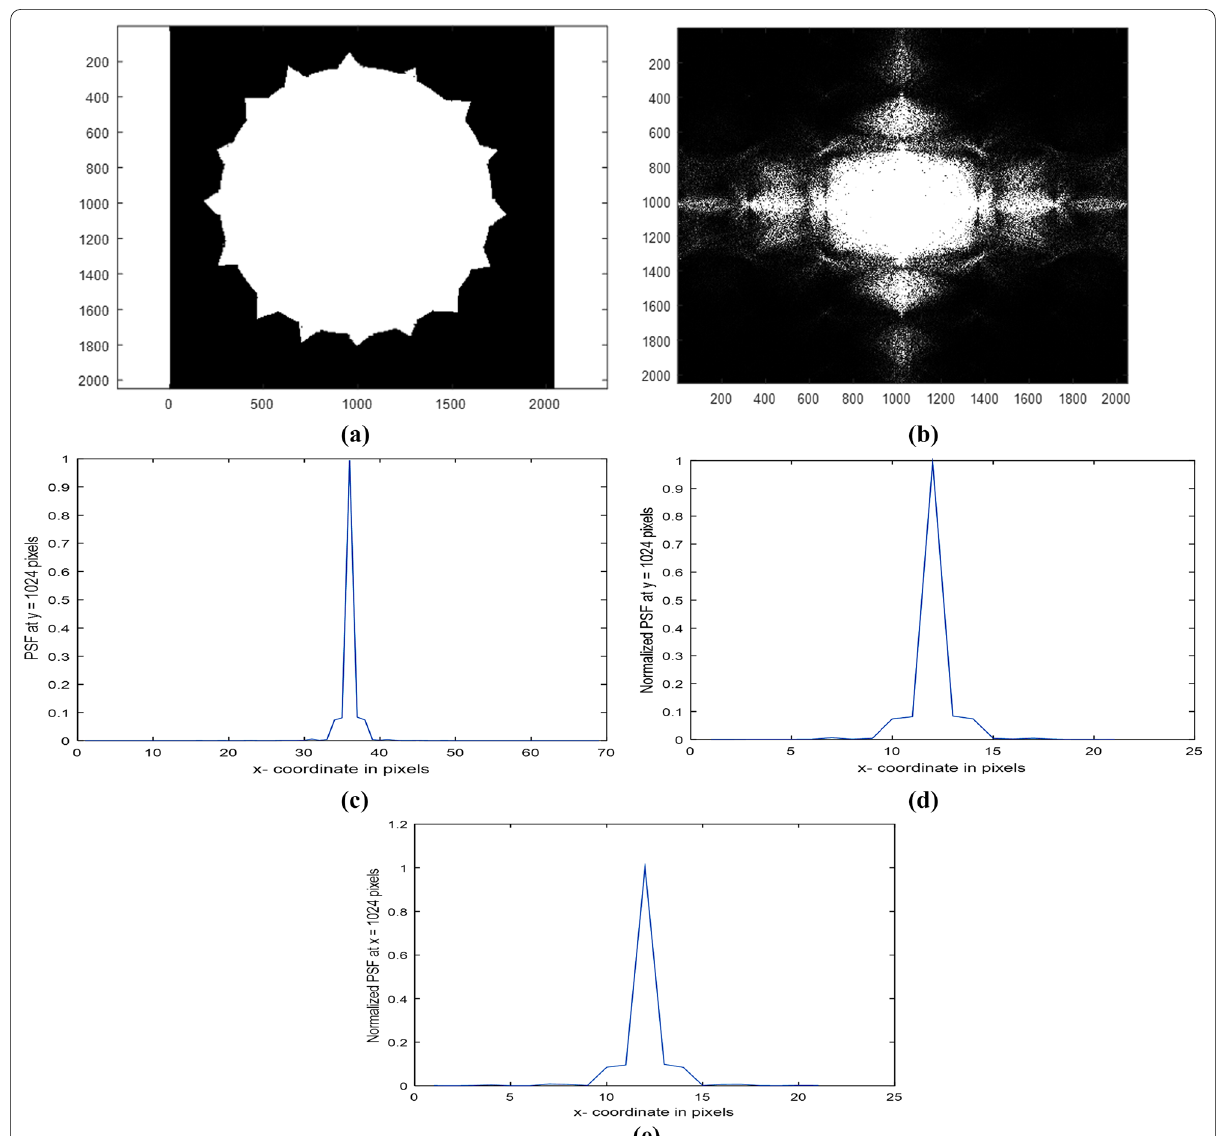
Fig. 4 a Uniform circular aperture with 16 spikes in a matrix of dimensions 2048 image or the intensity impulse response is corresponding to the aperture of 16 spikes shown in ( a ). c : The Normalized PSF plot in the range from 990 up to 1058 pixels is corresponding to the image shown in the (4- a). (4- d): The Normalized PSF plot in the range from 1014 up to 1034 pixels at y 1024 pixels is corresponding to the image show4n in ( a ). e : The Normalized PSF plot in the range from 1014 up to 1034 pixels at x = is corresponding to the image shown in ( a